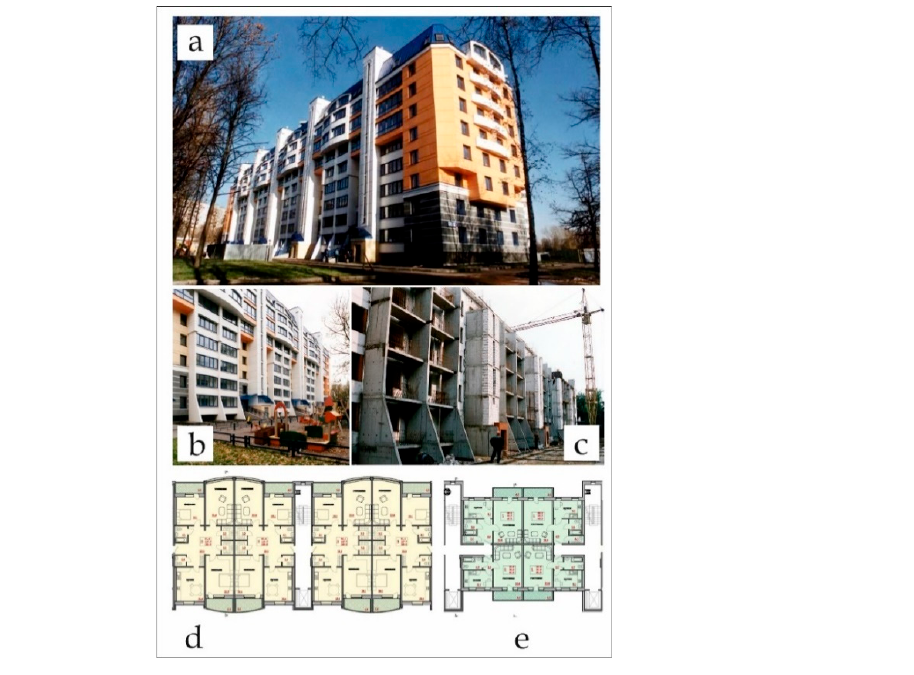
Figure 10. Reconstruction of a house with a superstructure of floors according to project A. Krotov: ( a , b ) The general view of the house after reconstruction. ( c ) The reconstruction process. ( d , e ) Variants of planning solutions, with the organization of a staircase–elevator hall and a change in the apartment. (https://www.akrotov.ru (accessed on 15 January 2022)).